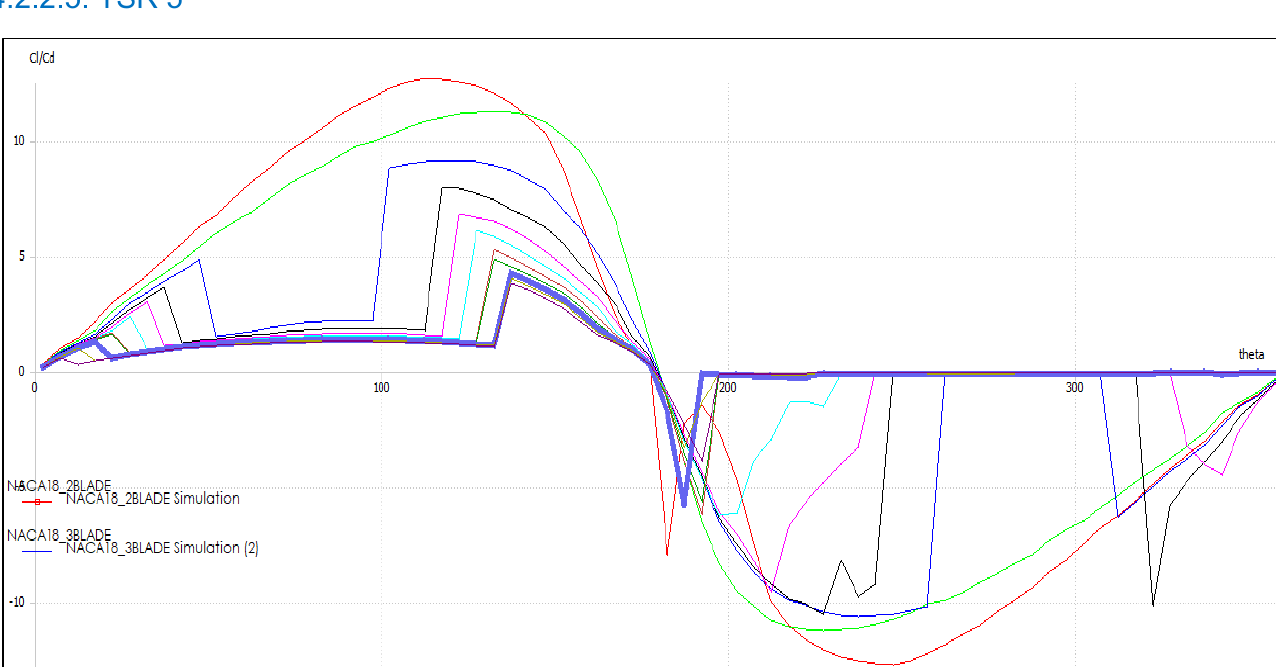
Figure 35. Cl/Cd vs theta plot of top-section for TSR 5